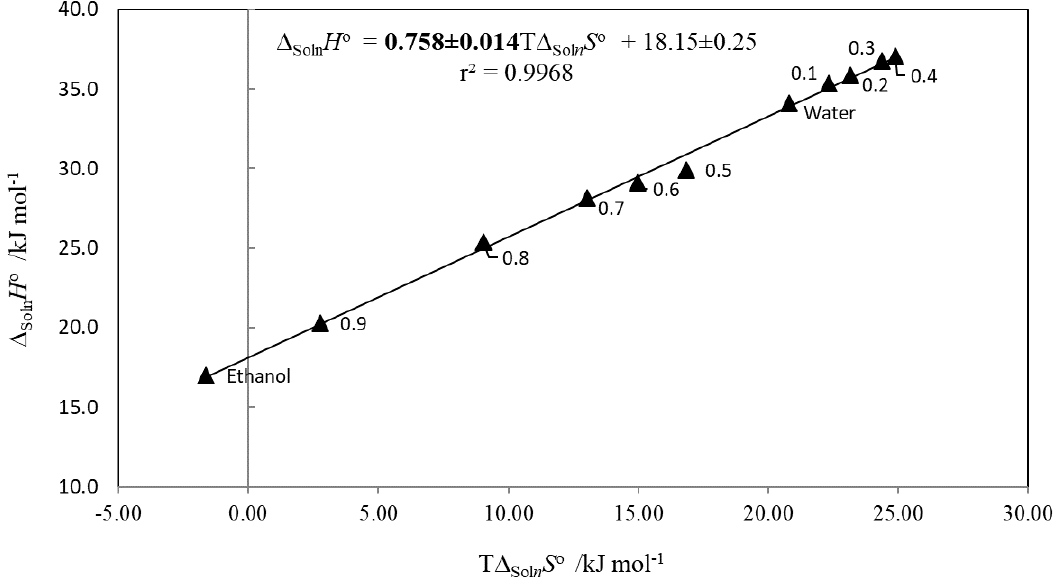
Figure 6. Enthalpy–entropy compensation graph of ∆ soln H o vs. T ∆ soln S o at T hm = 310.22